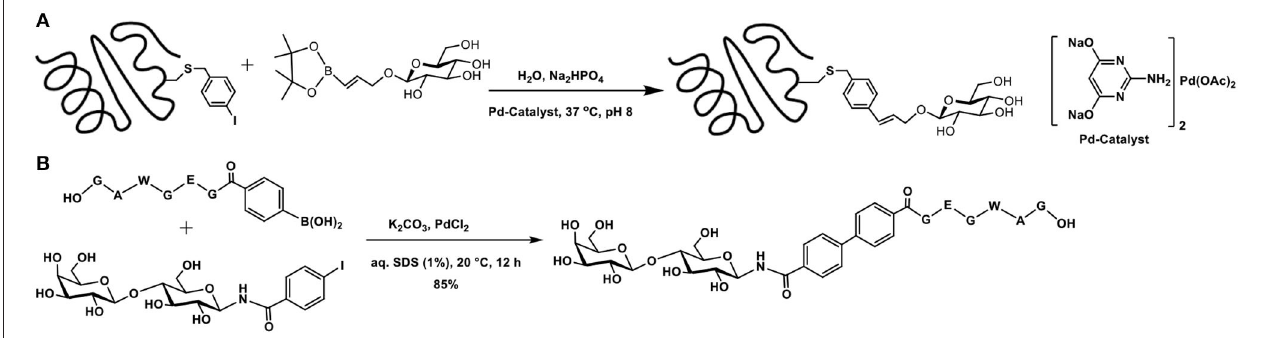
Concerning glycoconjugations, Suzuki-Miyaura